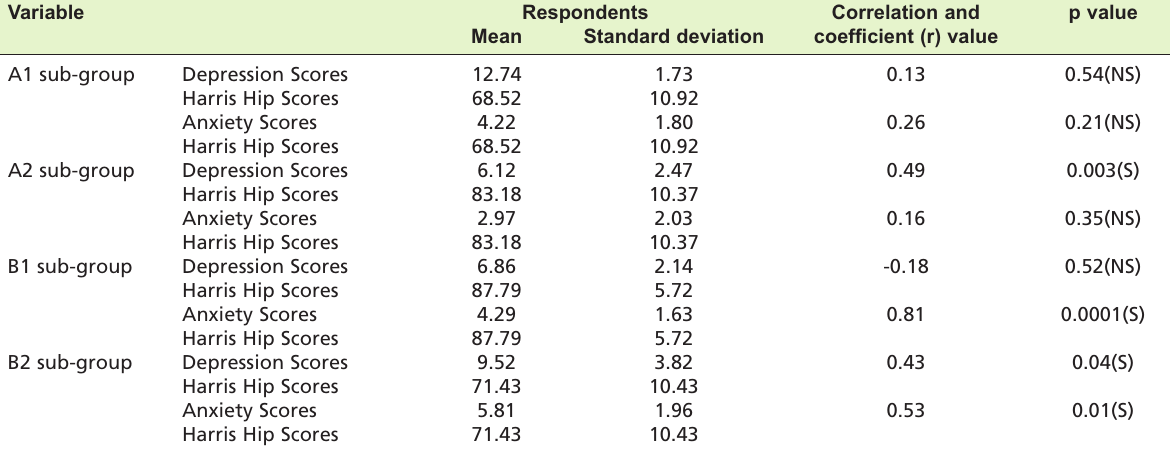
Correlation between psychological status (depression, anxiety) and functional outcome among participants in Table III: